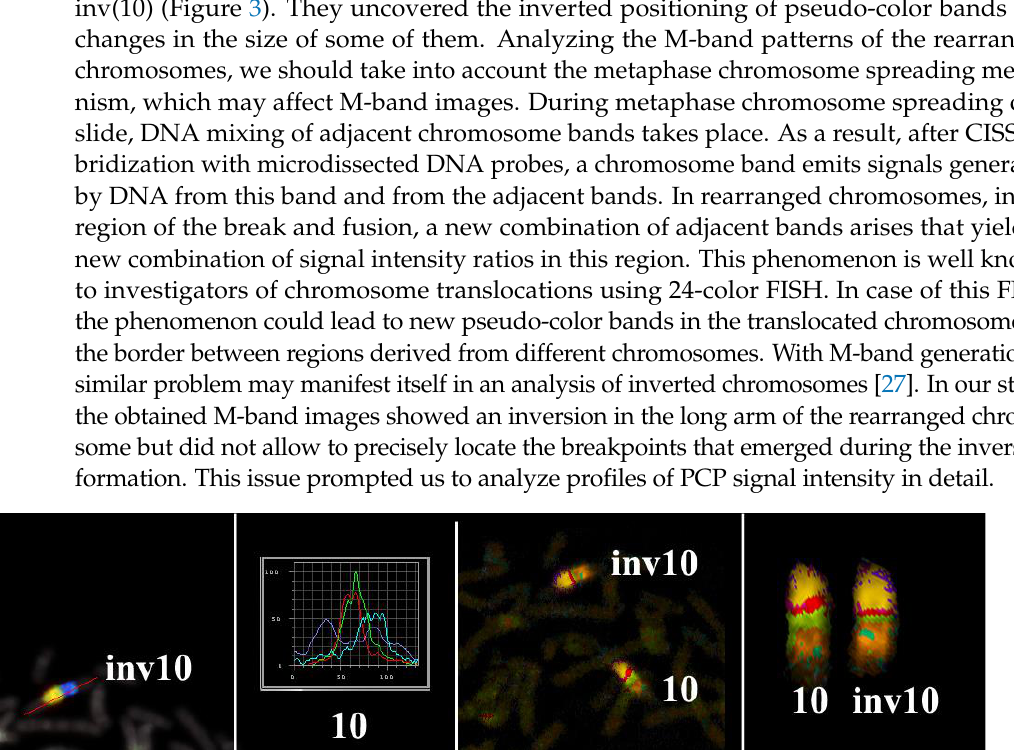
7 of 20 Figure 2. CISS hybridization of microdissected partial chromosome paints (PCPs; specific for three regions of human chromosome 10) with metaphase chromosomes of a healthy individual. ( a ) PCP10A (red signal), ( b ) PCP10B (green signal), and ( c ) PCP10C (green signal). ( d ) Fluorochrome profiles of homologous chromosome 10. The red line along the body of the chromosome is the line along which the profile of the relative signal intensity was determined. DAPI-stained chromosomes are blue. → indicates signals produced by the probe set on chromosome 10. * and ** mark the two homologous chromosomes 10. Metasystems Software developed for obtaining M-bands (MetaSystems Hard & Soft- ware GmbH, Altlussheim, Germany) converted the combination of mathematical ratios